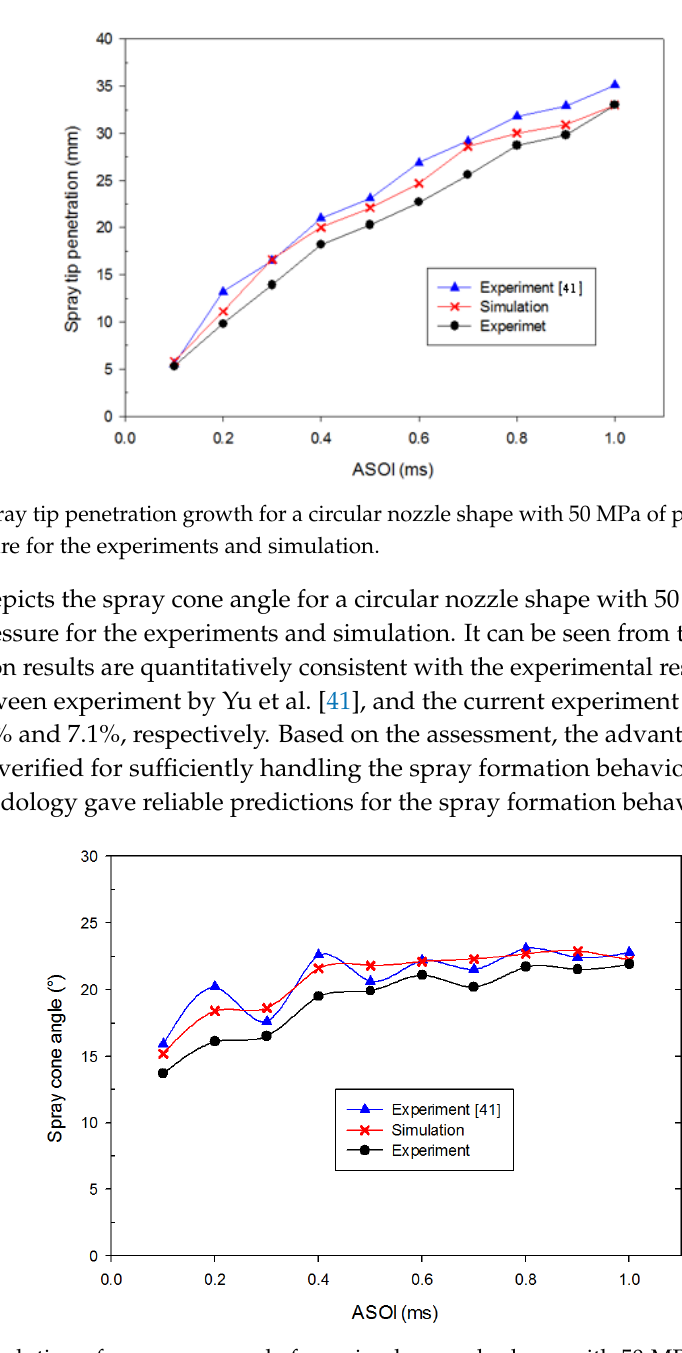
Figure 11. Evolution of spray cone angle for a circular nozzle shape with 50 MPa of pressure and 3 MPa of backpressure for experiments and simulation.